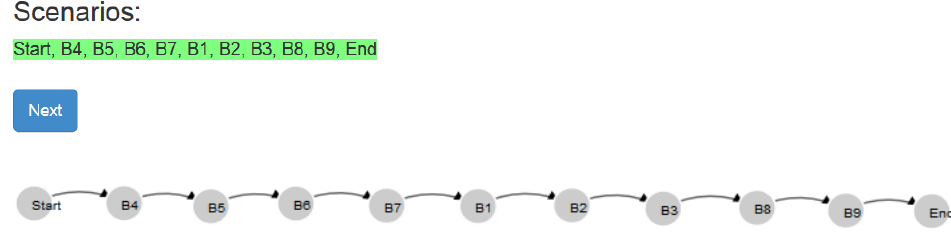
Figure 6. A candidate model process corresponding to the first performed scenario.